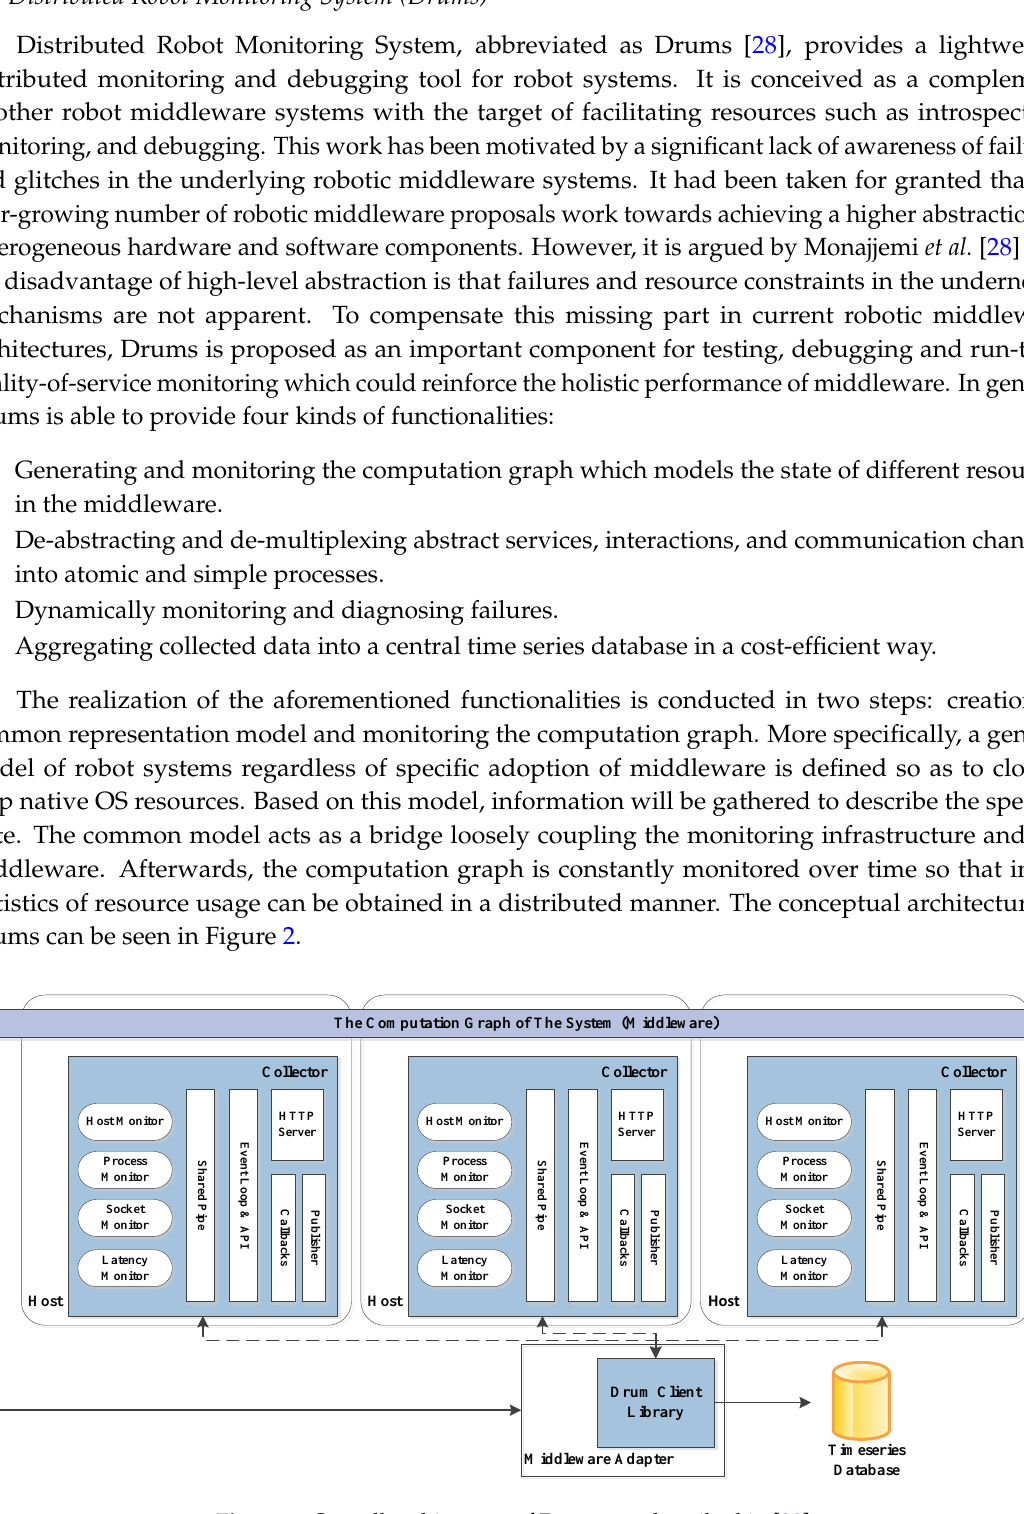
Figure 2. Overall architecture of Drums, as described in [28].